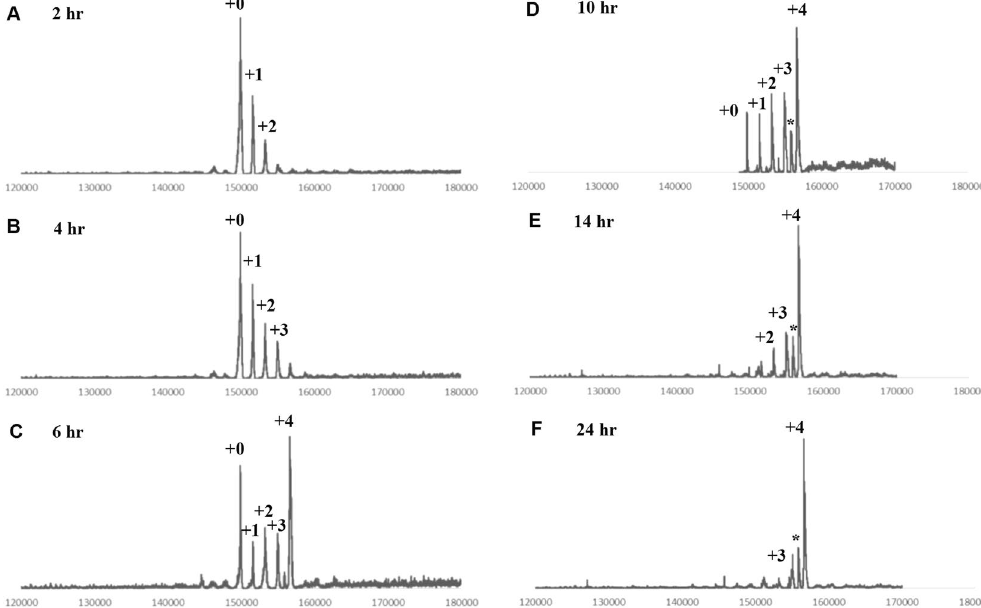
Figure 6. Real-time DAR analysis of gsADC 9 . The click reaction of DBCO-MMAE ( 8 ) with azido-herceptin ( 7 ) was monitored at ( A ) 2 hr; ( B ) 4 hr; ( C ) 6 hr; ( D ) 10 hr; ( E ) 14 hr; and ( F ) 24